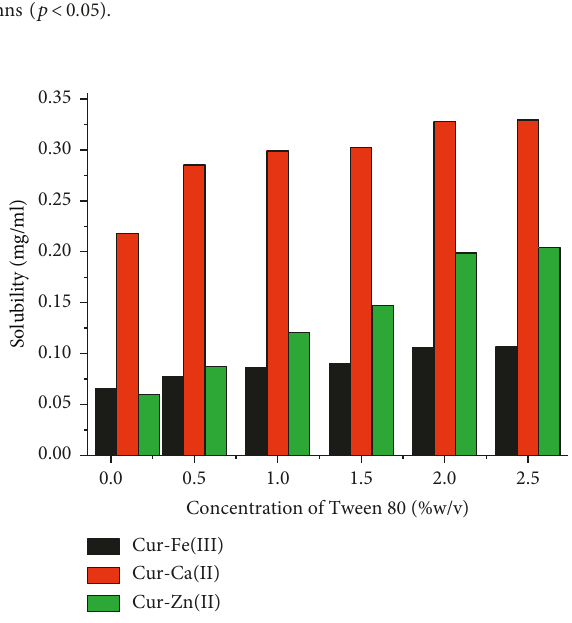
Figure 4: The effect of Tween concentration on the solubility of curcumin metal complex.